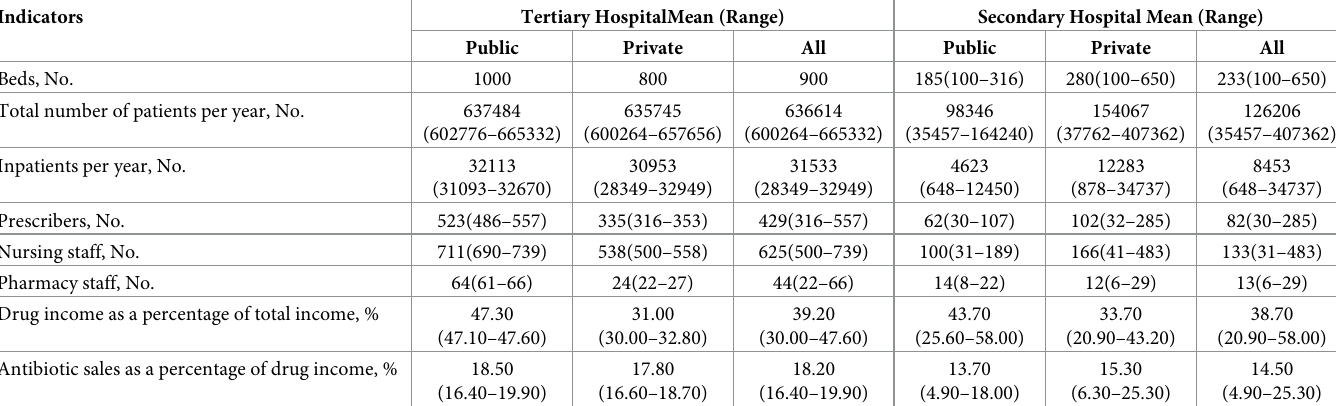
Table 1. General characteristics of hospitals.